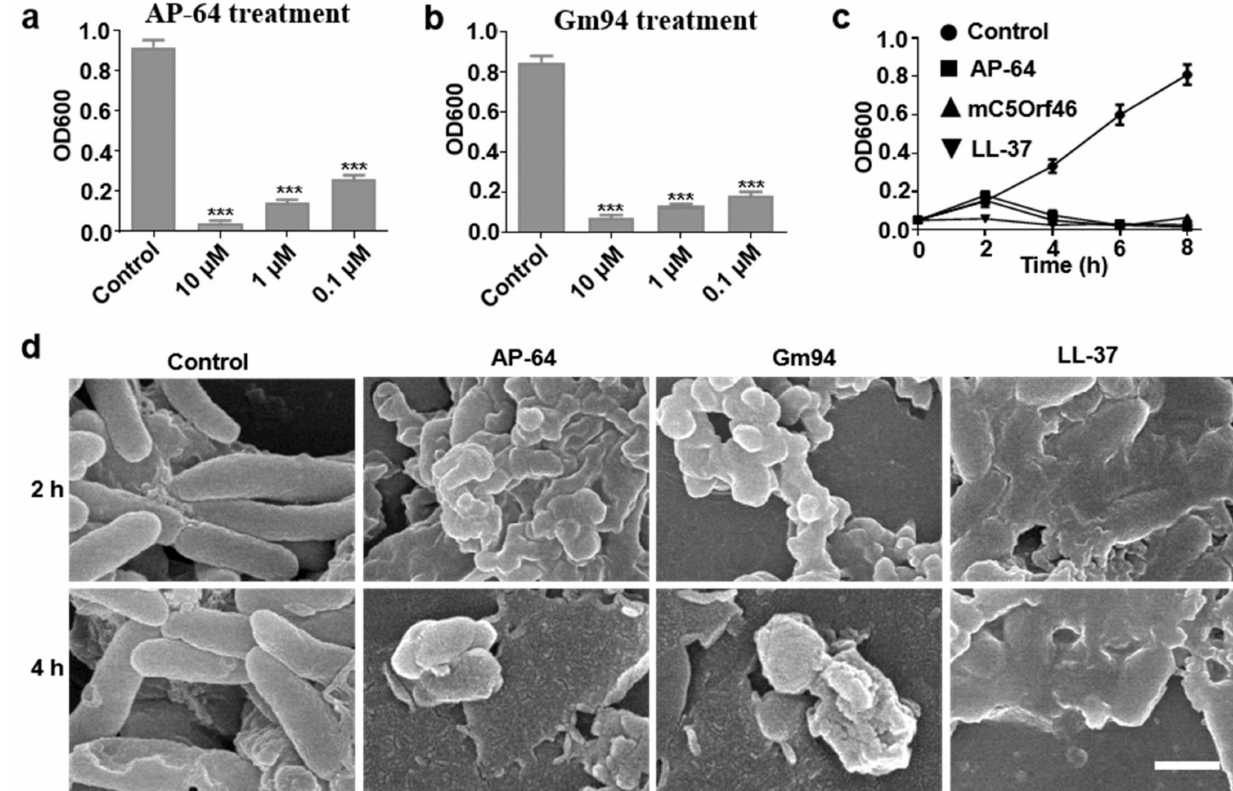
Figure 3. Antibacterial activity of AP-64 and Gm94 against DH5 α cells. ( a , b ) OD600 value of DH5 α cells exposed to the indicated concentrations of AP-64 and Gm94 for 8 h. Data are mean ± SD of three independent experiments with each experiment conducted in triplicate. *** p < 0.001. ( c ) OD600 value of DH5 α cells treated with the indicated proteins (10 µ M) at different time points. The proteins were added to the bacteria at time 0. All error bars represent standard deviation (SD). ( d ) SEM assay of DH5 α cells after treatment with indicated proteins. DH5 α cells were grown in LB to an OD600 of 0.1. The cells were treated with the indicated proteins (10 µ M) at 37 ◦ C. Scale bar, 1 µ